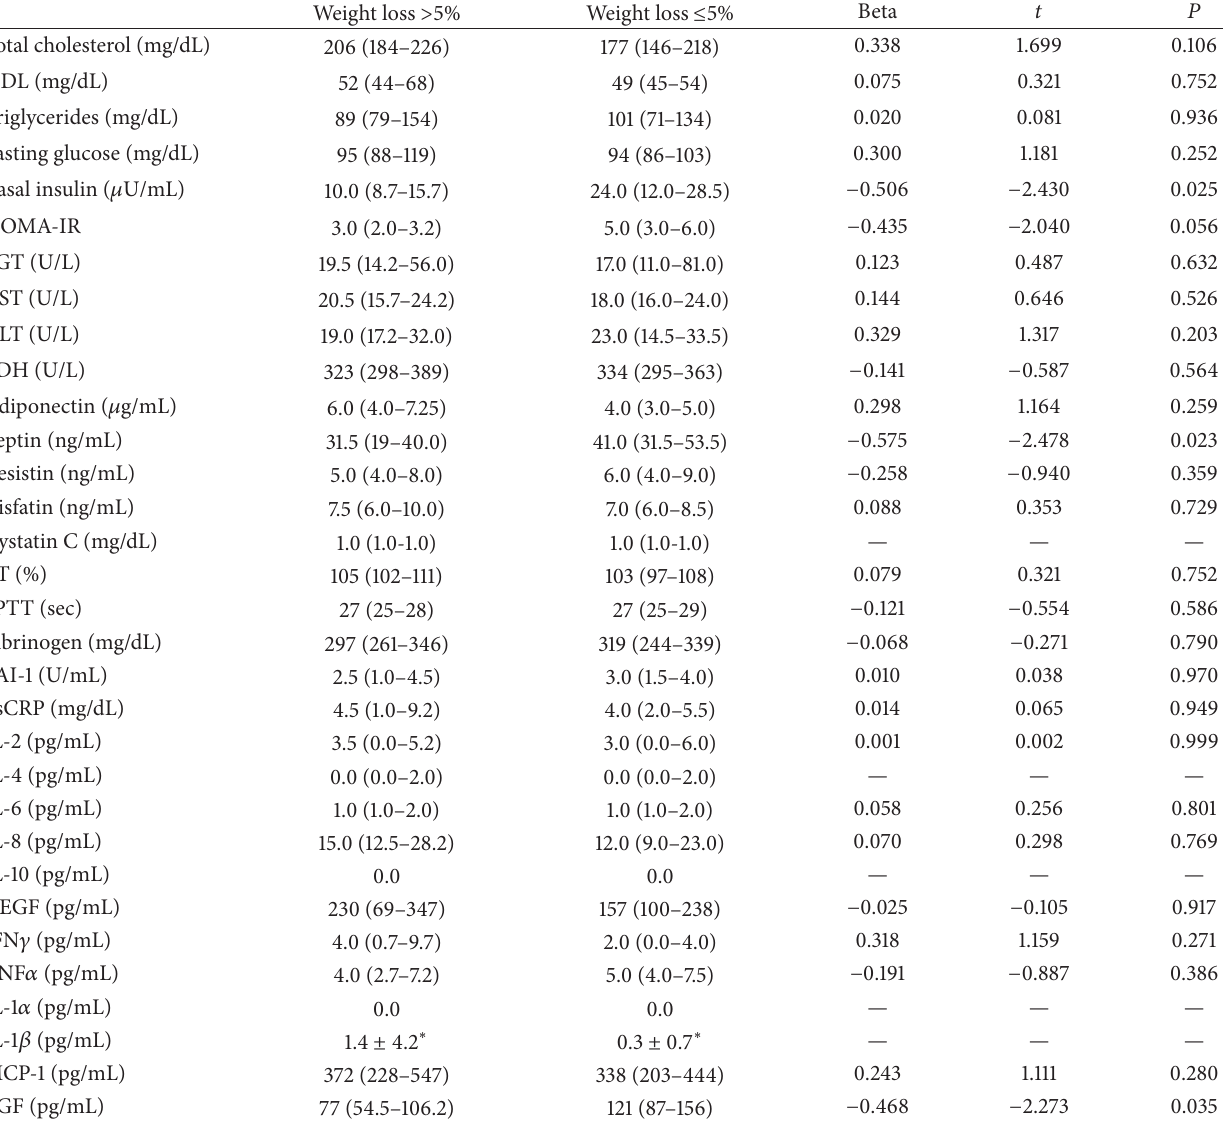
Table 4: Effect of weight loss on biochemical